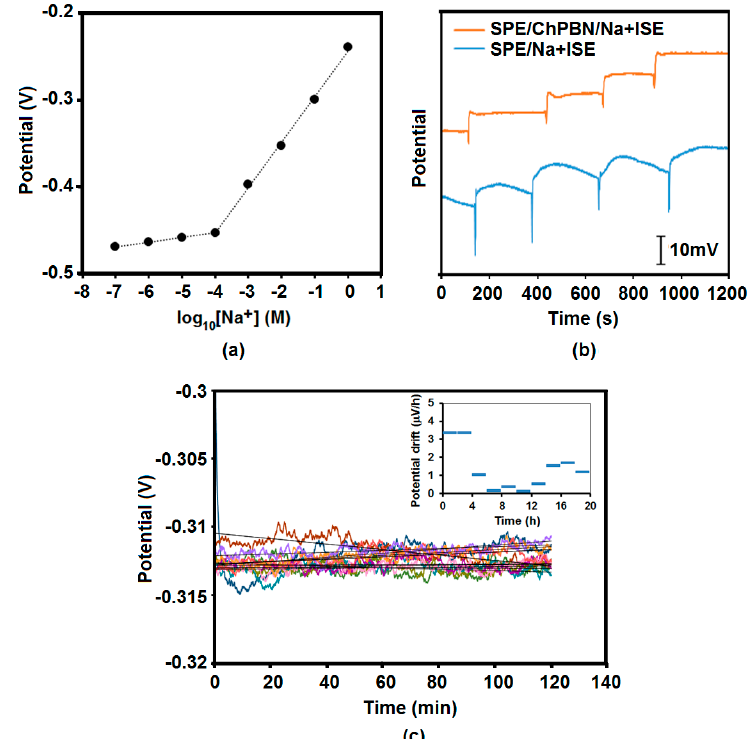
Figure 6. Calibration curve and potential stability study of SPE/ChPBN/Na + ISE: ( a ) The variation of open circuit potentials of SPE/ChPBN/Na + ISE with respect to [Na + ] ranging from 10 − 7 –1 M. Here, a near Nernstian slope (52.4 mV/decade) was obtained in the concentration range between 10 − 4 and 1 M; ( b ) Zero current potentiometry of SPE/Na + ISE and SPE/ChPBN/Na + ISE with respect to